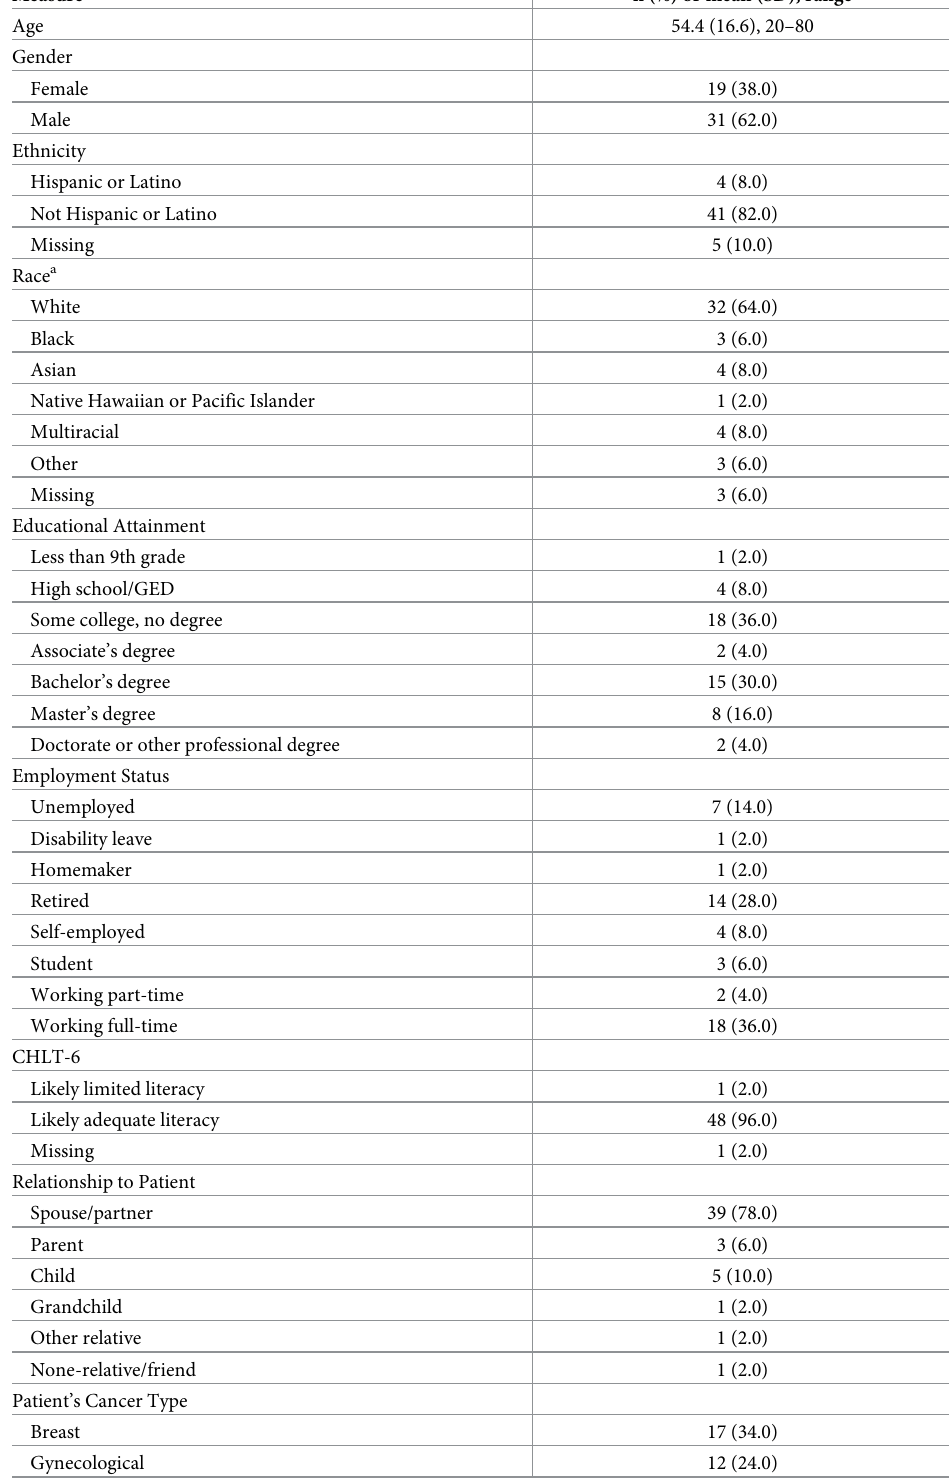
Table 2. Participants’ self-reported background characteristics at baseline (n =